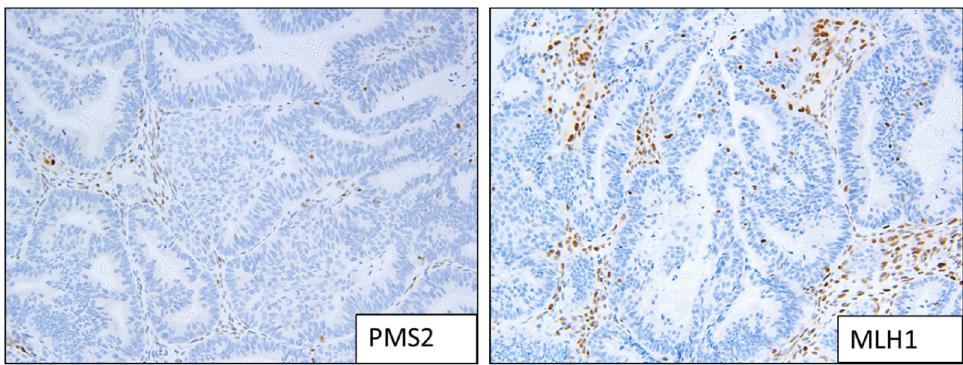
Figure 2. Example of MMRd staining patterns; loss of expression of MLH1 and PMS2.